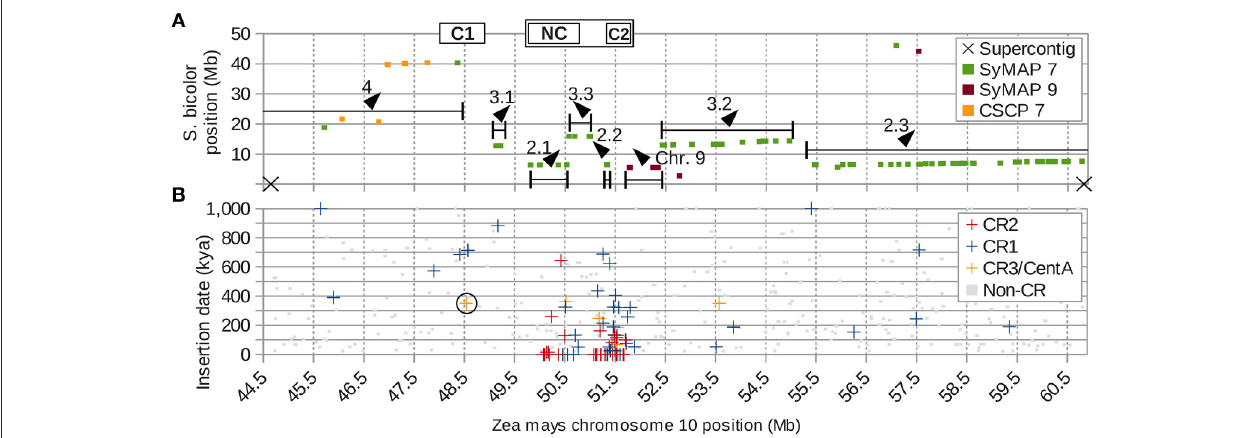
FIGURE 7 | Supercontig of CEN10 and hemicentric inversions. (A) Seven jumbled blocks of syntenic sorghum chromosome 7 markers (SyMAP 7) are numbered according to their positions in sorghum, with direction indicated by arrows. Boxed C1 and C2 indicate positions of the CentC clusters, NC indicates the CR cluster with no CentC ( Figure 1 ). The cenH3 binding region CEN10 is marked by the box surrounding NC and C2. Single-copy pericentromere markers conserved between sorghum and maize (CSCP) are shown. CSCP 7 markers of sorghum chromosome 7 are near C1. Sorghum chromosome 9 markers (SyMAP 9) that originated from the end of a larger syntenic block 40 Mb away (Figure S10) were deposited near CEN10 of maize by several inversions involving centromere-proximal DSBs, which are confirmed by the presence of a CR1 element at the distant end of the SyMAP 9 block (Figure S9B). Ends of blocks do not coincide with either of the two supercontig breaks in this region of the reference genome, indicating that breaks in synteny are real and not artifacts of sequence assembly. (B) CR and non-CR elements graphed by estimated insertion time and chromosome location indicate that C1 has become inactive > 300 kya. The CR element used to date the split of C1 from C2 resulting in inactivation of C1 is circled. CR3/CentA = CR3 and CentA (nonautonomous